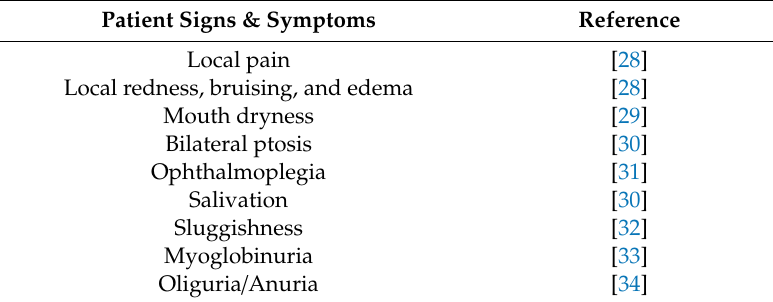
Table 2. Patient clinical